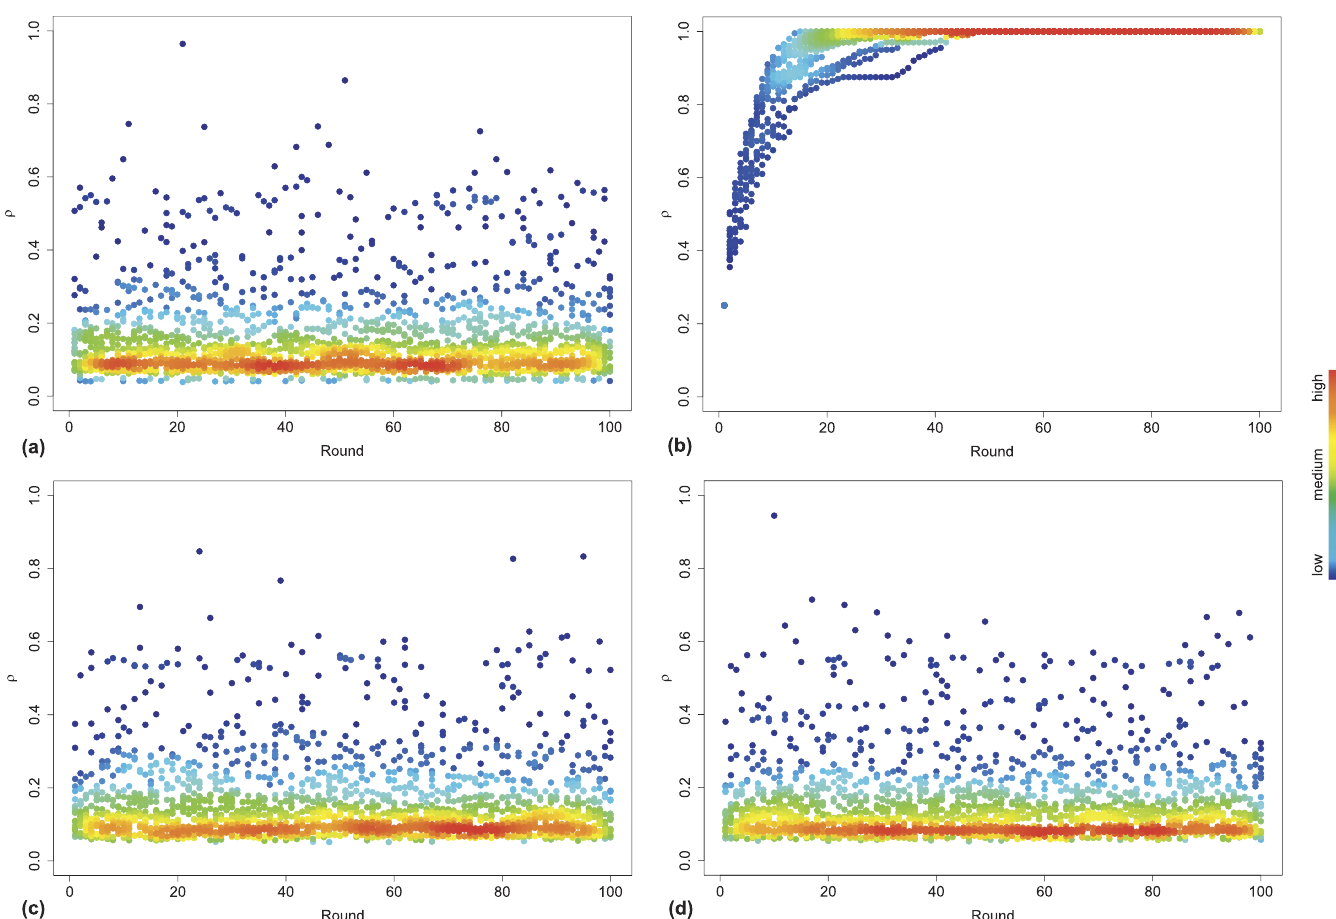
Fig 4. Evolutionary dynamics of the density of cooperative nodes over time. We show the fraction of cooperative nodes ρ i against the rounds or time steps ( t ) before feedback (a) and after the first feedback round (b), the second feedback round (c) and the third feedback round (d). ρ ranges in [0, 1], where 0 corresponds to the global defection, while 1 means a global cooperation of population. We simulated the evolutionary dynamics of the ISG for a fixed number of simulations, and the color, ranging from ‘blue’ to ‘red’, corresponds to the density ρ . We can observe a fluctuation in strategies determined by the feedback rounds from gut acting alternatively as i incentives towards cooperativeness (see (b)) and a coexistence of the two strategies, with more defectors than cooperators (see (a), (c) and (d)).